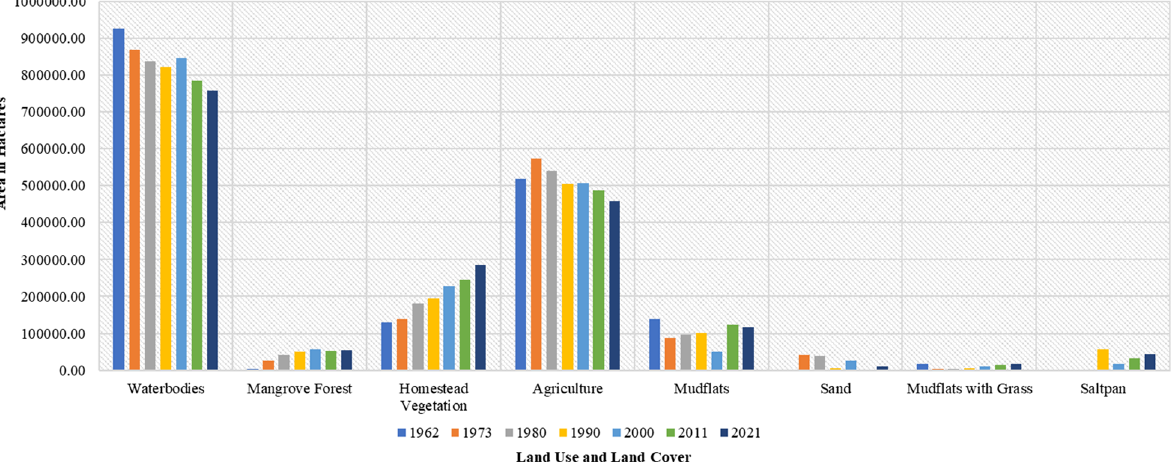
Fig. 6 Land use and land cover statistics by year